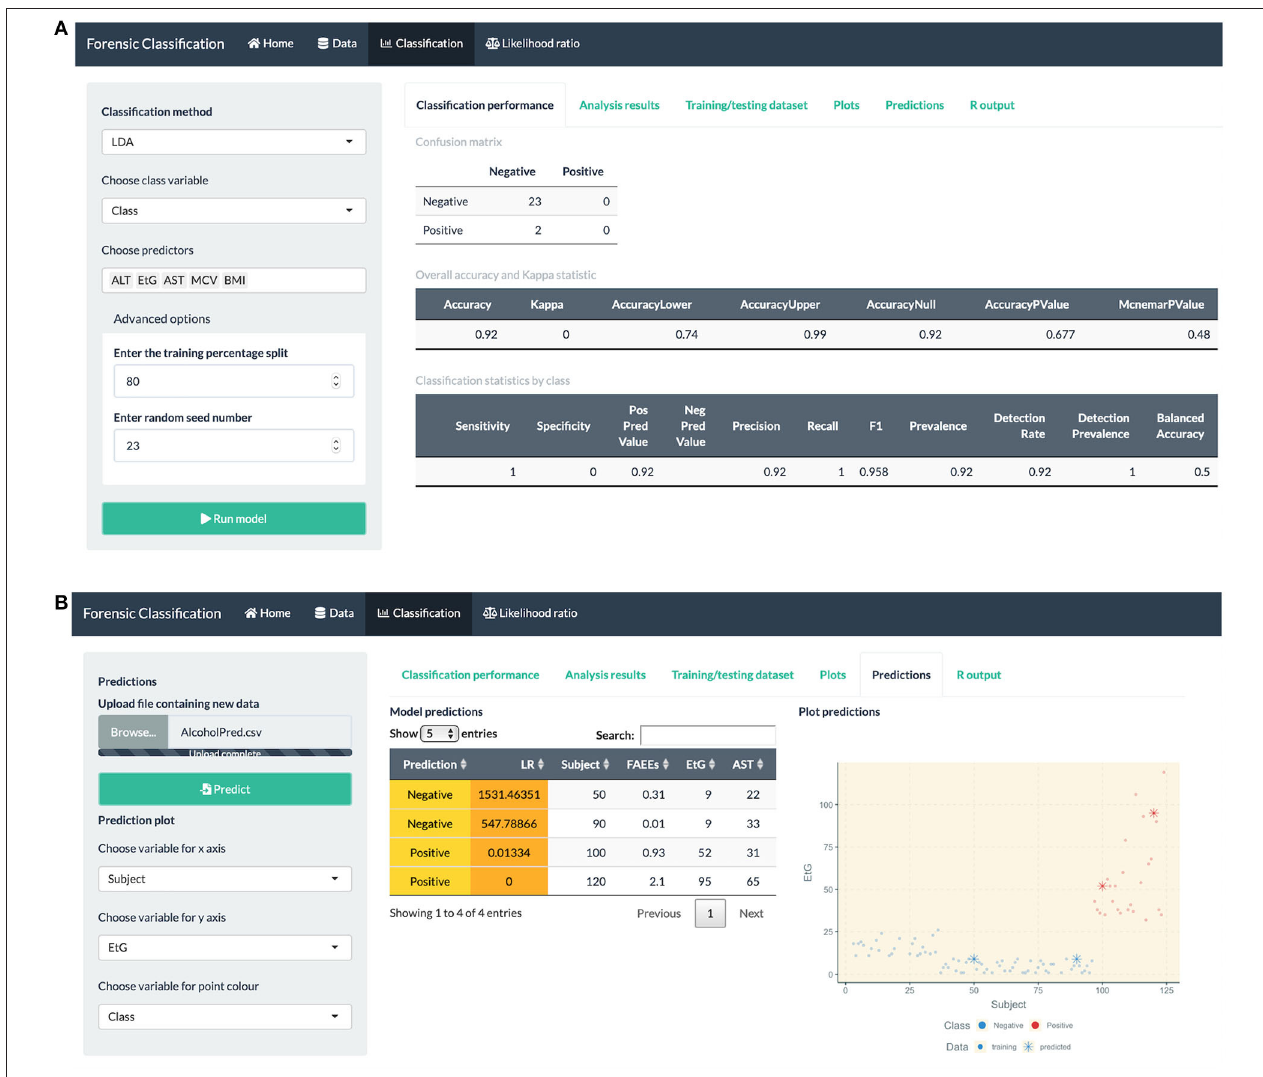
FIGURE 5 | R Shiny app: “Classification” tab screenshots, showing (A) confusion matrix and model performance measures: sensitivity, precision, recall, etc. for the alcohol biomarkers dataset (B) prediction table, including the predicted class and LR for each observation, and plot showing the training and predicted